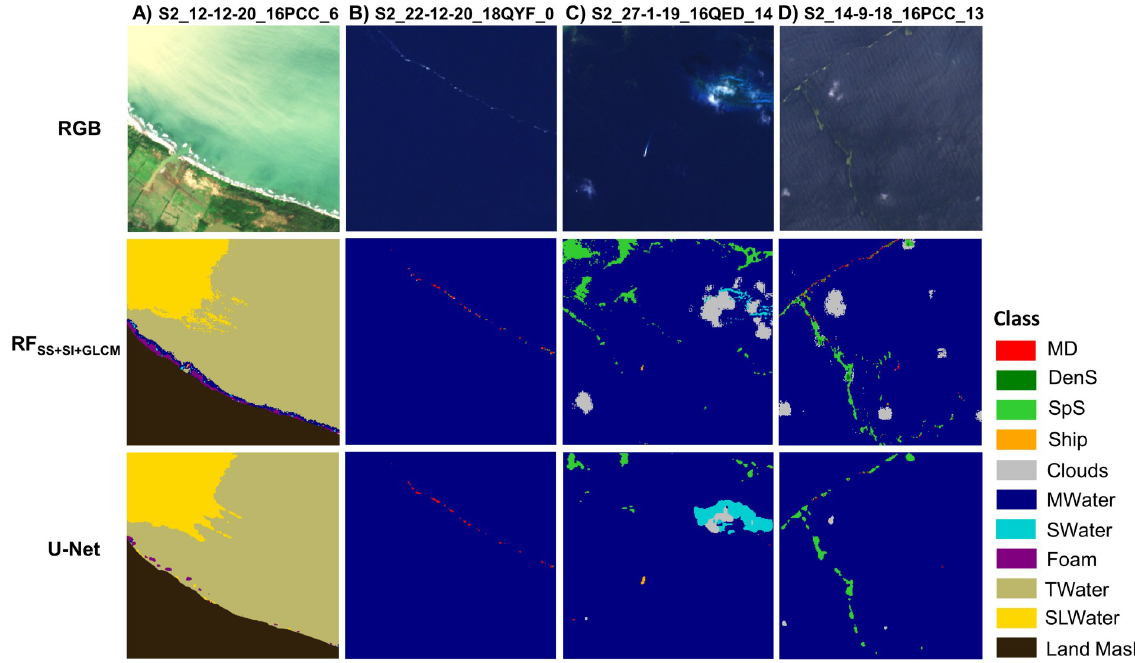
Fig 5. Classification results extracted by the baseline RF SS+SI+GLCM and U-Net models. Selected indicative cases demonstrate (A) S2_12-12- 20_16PCC_6, (B) S2_22-12-20_18QYF_0, (C) S2_27-1-19_16QED_14 and (D) S2_14-9-18_16PCC_13 patches on test set. RGB patches are derived from Sentinel-2 data which were freely downloaded from https://earthexplorer.usgs.gov/. All acronyms are stated in Table 2.